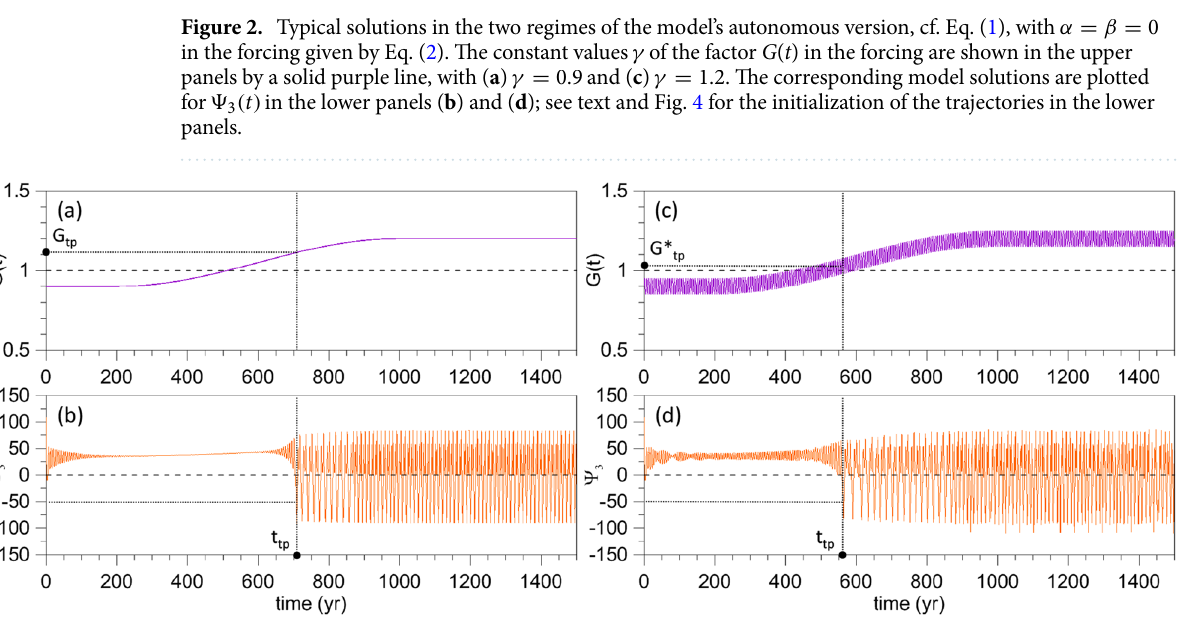
Figure 3. Transition from the excitable regime to the RO regime for a ramp forcing in Eq. (2). ( a ) Time dependence of the factor G ( t ) in the forcing for γ = 0.9 < γ c = 1 , α = 0.3 , τ = 800 year, and β = 0 ; ( b ) corresponding response of � 3 ( t ) ; see text for the choice of initial states. ( c , d ) Same as panels ( a , b ) but for β = 0.05 and perturbation period T = 5